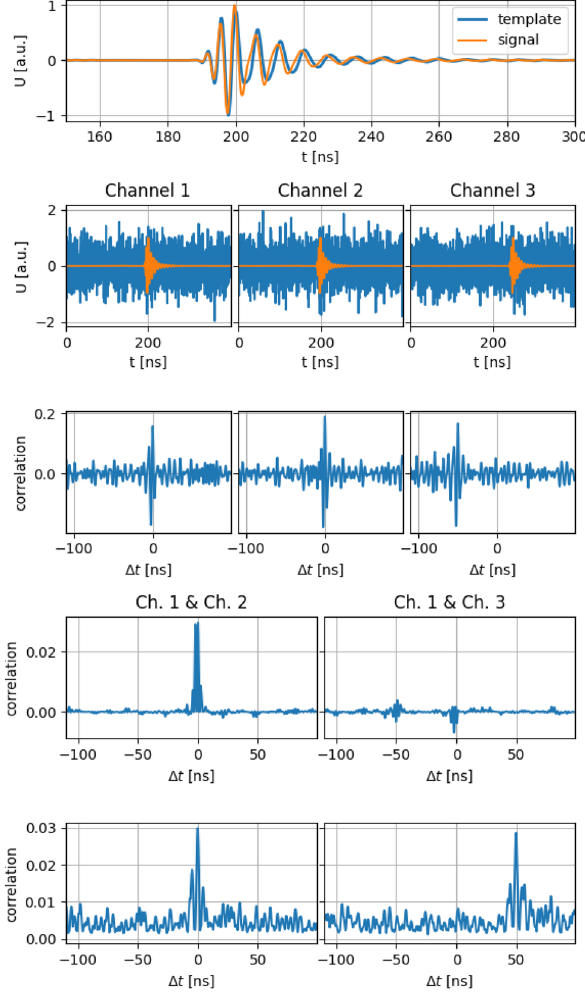
Fig. 3 Visualization of the template correlation method to determine the timing differences between channels. Top row: Zoom of waveforms of signal and template. Second row: Noisy waveforms (blue) and the original signals (orange) of three different channels. Third row: Corre- lation of those waveforms with the template. Fourth row: Product of the template correlation for channel 1 with those for the other two chan- nels. Bottom row: Maximum of the product of the correlations for two channels as a function of the time shift applied to one of them